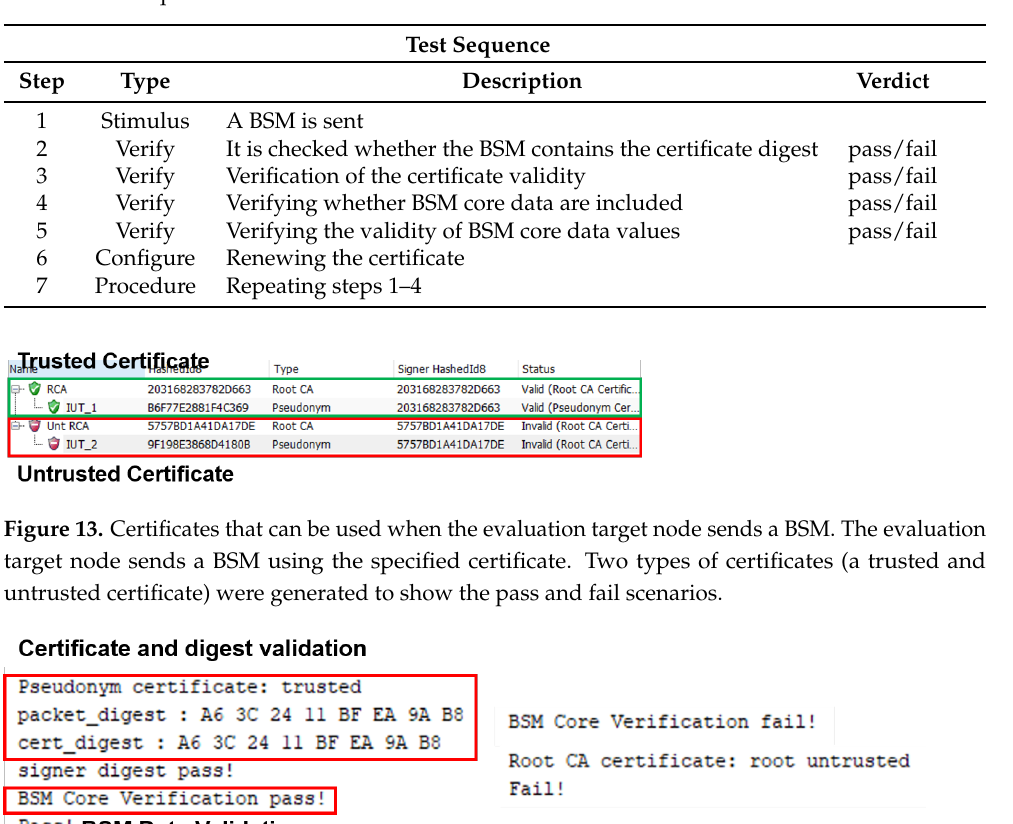
Table 5. Test sequence of Evaluation Scenario 1.